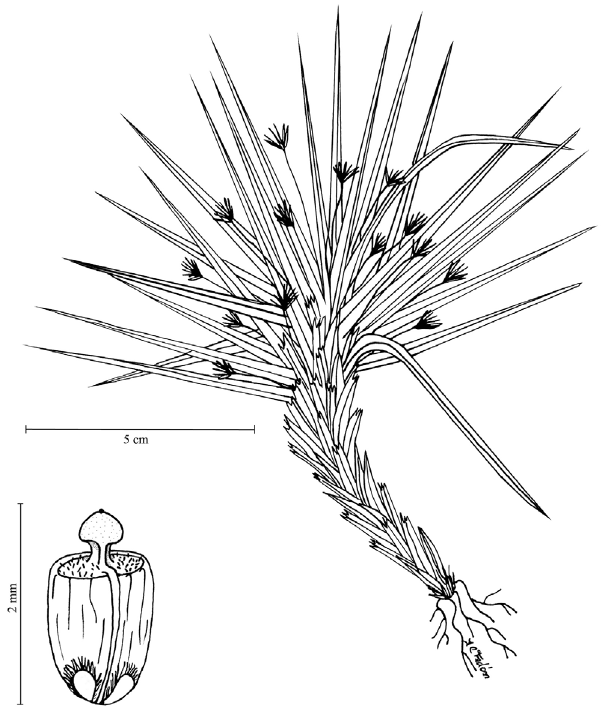
Figure 2. Cephalocarpus confertus Whole individual of achene (Drawing: I. C.